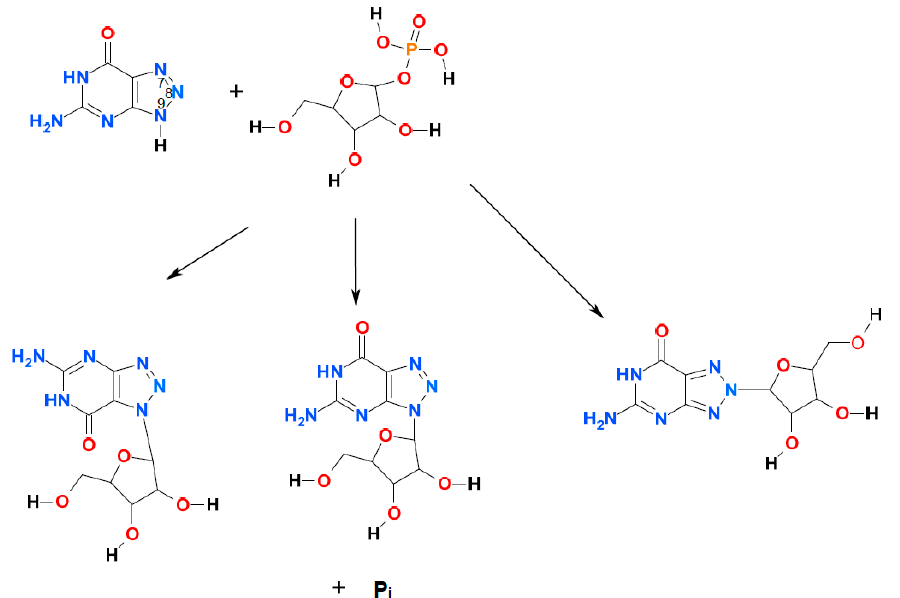
Figure 1. Ribosylation of 8-azaguanine with α - D -ribose-1-phosphate: possible reaction products. The purine numbering is maintained for simplicity. Only the major tautomeric form of 8-azaguanine (N(9)H) is shown.